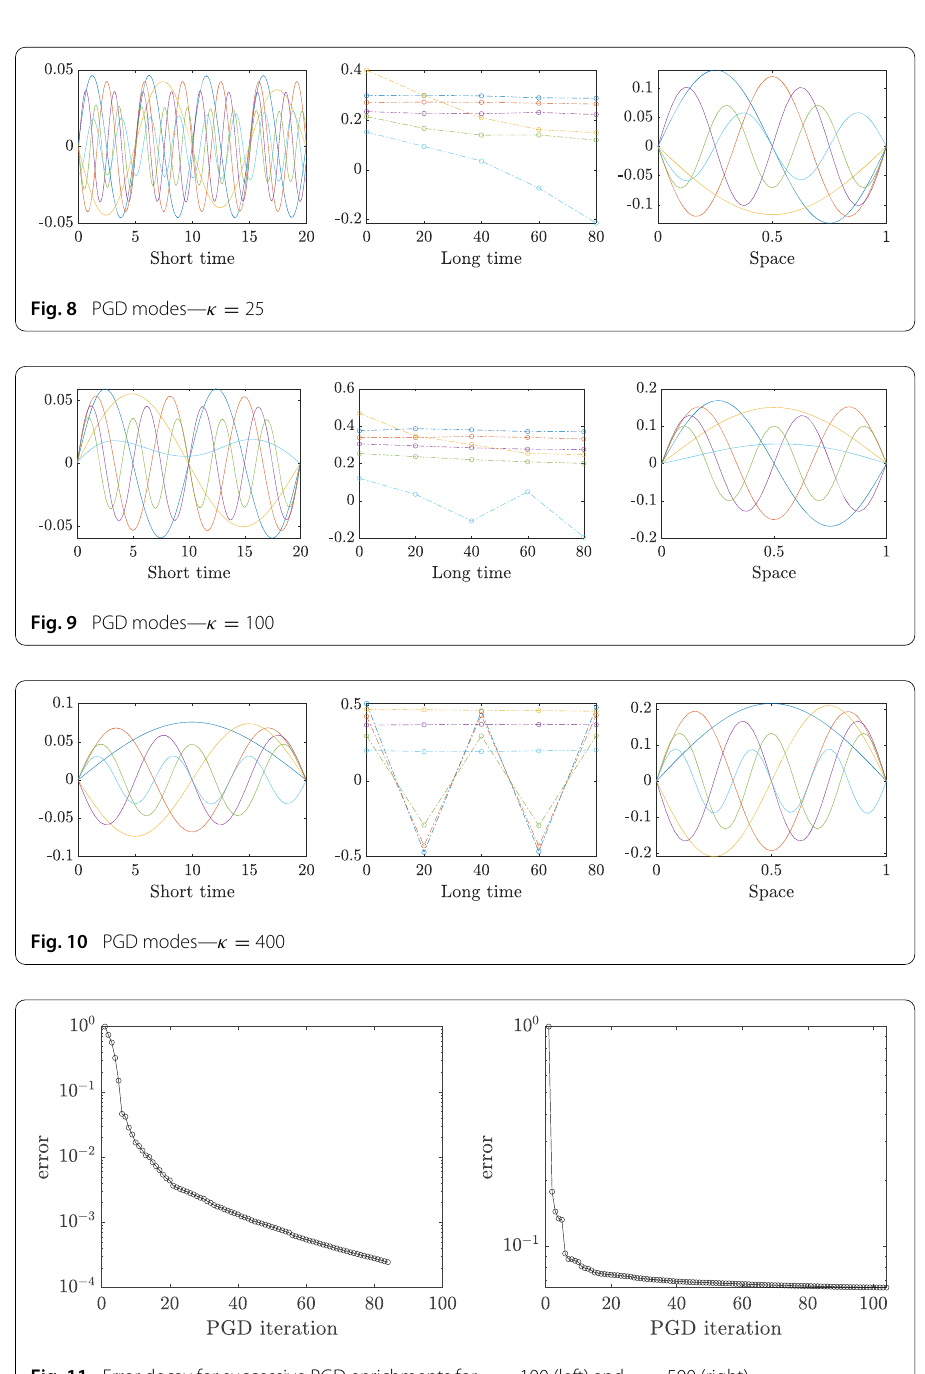
adopted, causing a delay between macro-dofs and reflection. This discrepancy is evident, for instance, by the low accuracy characterizing the contour plot in the bottom-right panel of Fig.